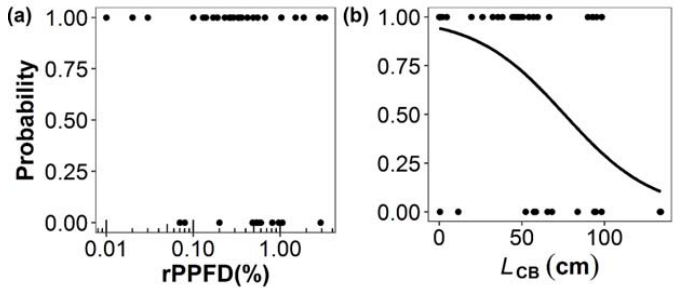
Figure 2. Effects of ( a ) natural-log transformed relative photosynthetic photon flux density (ln(rPPFD)); and ( b ) the length between the basal location of the primary branch and the crown base ( L CB , cm) on the probability of death (July 2013–July 2014) of a primary branch. In ( a ), the effects of ln(rPPFD) were not significant ( p = 0.18; see Table 1c). The coefficients of the curved line in ( b ) showing Equation (1) are given in Table 1.